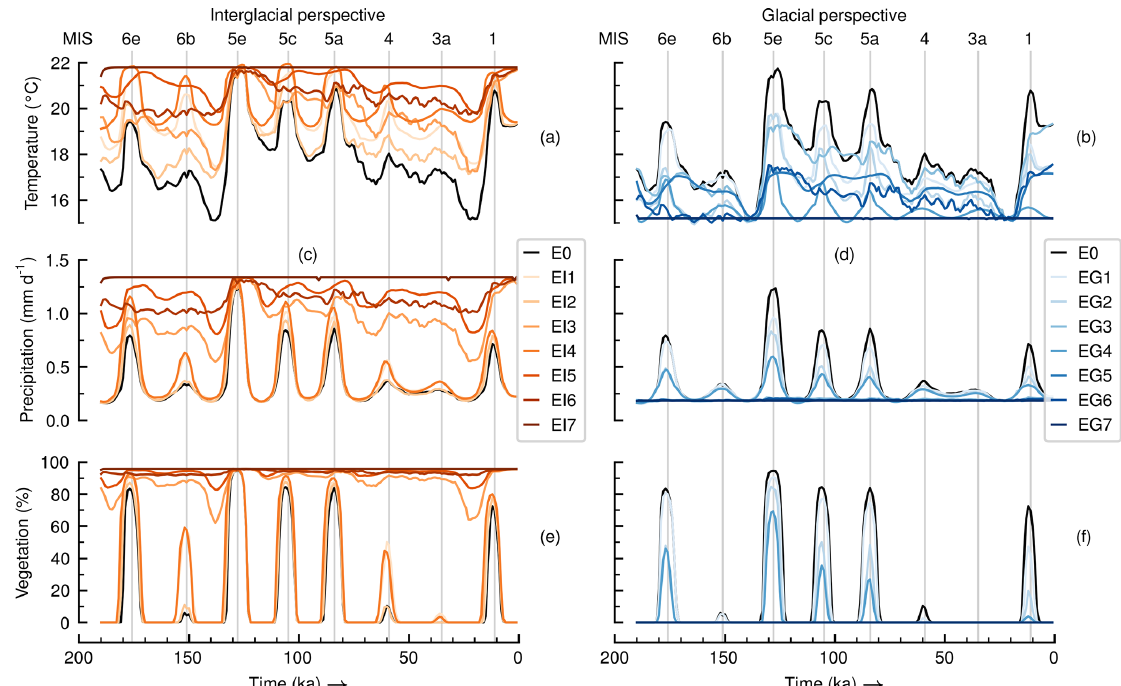
Figure A2. Results of annual means of (a, b) near-surface temperature, (c, d) precipitation and (e, f) vegetation cover fraction in the Sahara grid box for all simulations involved in the separation analyses from interglacial and glacial perspectives. Vertical lines indicate monsoon forcing index maxima and are labelled using MIS names on